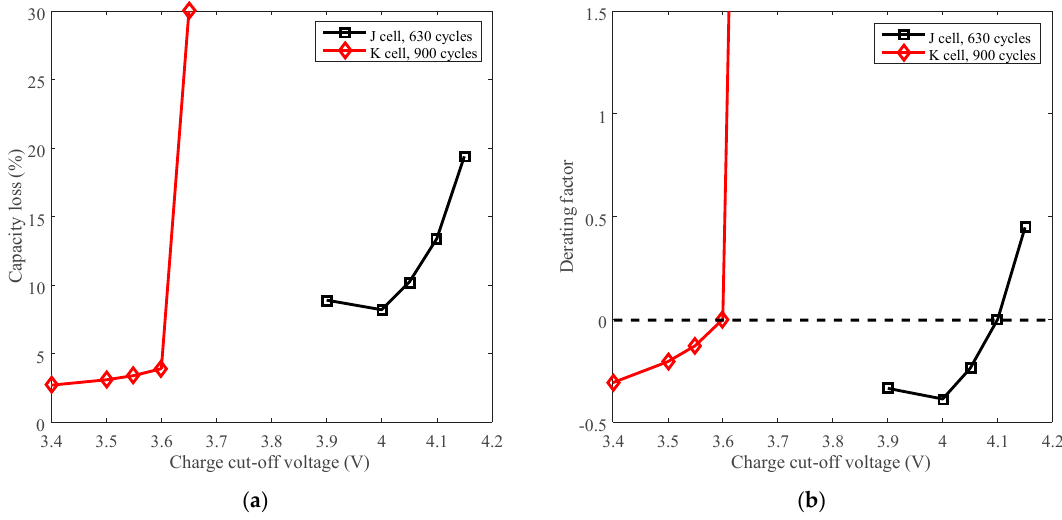
Figure 13. Derating of charge cut-off voltage. (a) Capacity loss vs. cut-off voltage. (b) Derating factor vs. cut-off voltage.